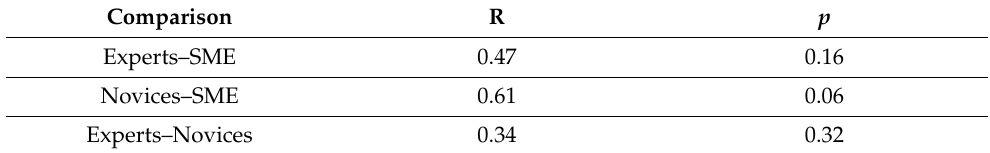
Figure 6. Median MEF index of the Experts (blue bar) and Novices (orange bar) estimated from their brain activity across the different flight phases. Significant difference ( p = 0.035) was found between the two groups. The asterisk means that the differences were statistically significant ( p < 0.05). Furthermore, replicating the statistics on the MEF index within each different flight phase of the simulation, the results highlight a very interesting aspect (Figure 7). Regard- less of whether the flight phase was a standard one such as taxi (TAXI), takeoff (TOFF) or landing (LAND), the two groups required a similar ( p > 0.05) amount of mental effort. However, during unusual conditions such as the resolution of the first failure (FAIL_E) and the recoveries from the unusual attitudes (UPSET_1, UPSET_2, UPSET_3), the Nov- ices (orange line) exhibited significantly higher mental effort requests than the Experts (blue line).